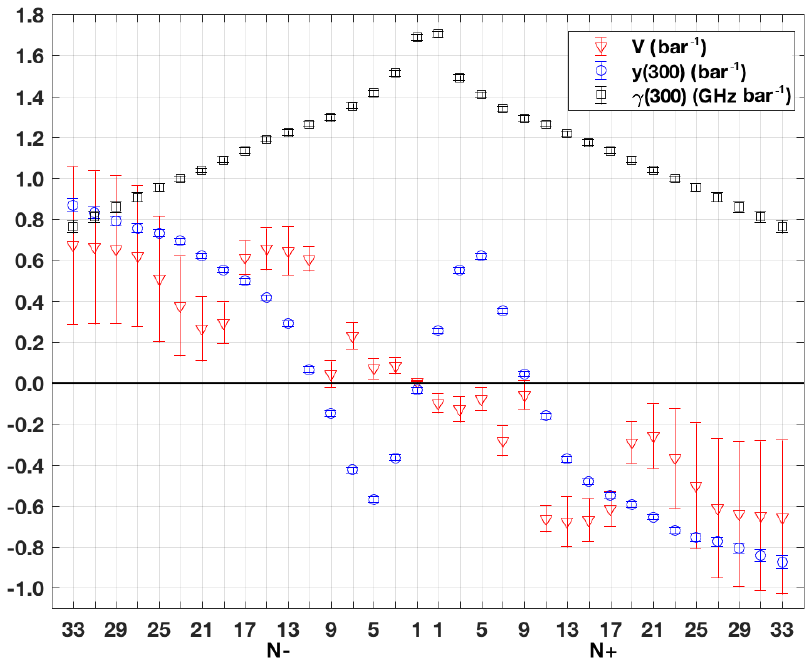
Figure 5. Oxygen line parameters as a function of rotational quantum number N : line width γ a (300) (squares), line mixing y( 300 ) (circles), and line-mixing temperature coefficients V (triangles). Error bars indicate ± 1 σ